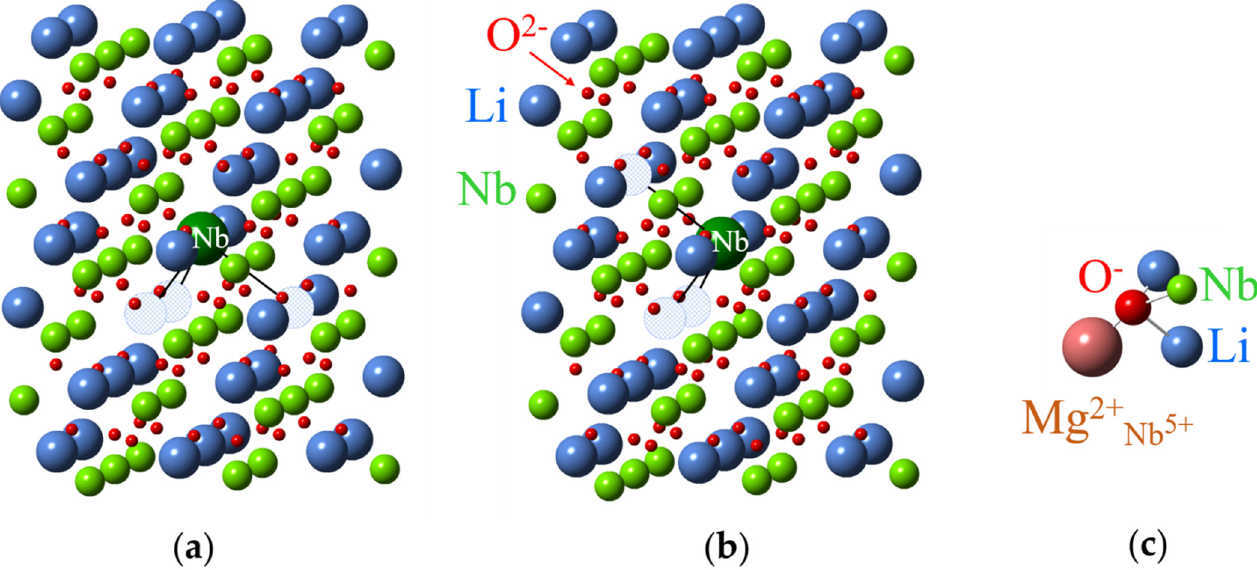
Figure 25. Models for Nb 4+ Li (large green ball) centers with three v Li in LN. Hatched circles represent lithium vacancies. ( a ) Axial center. ( b ) Low-symmetry center. ( c ) The center with O − near Mg 2+ substituted for Nb 5+ .